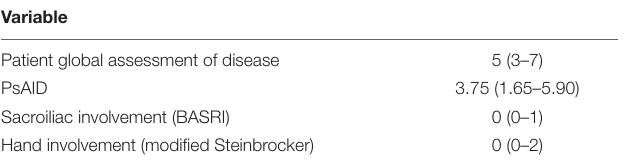
TABLE 1 | Baseline characteristics of the sample.